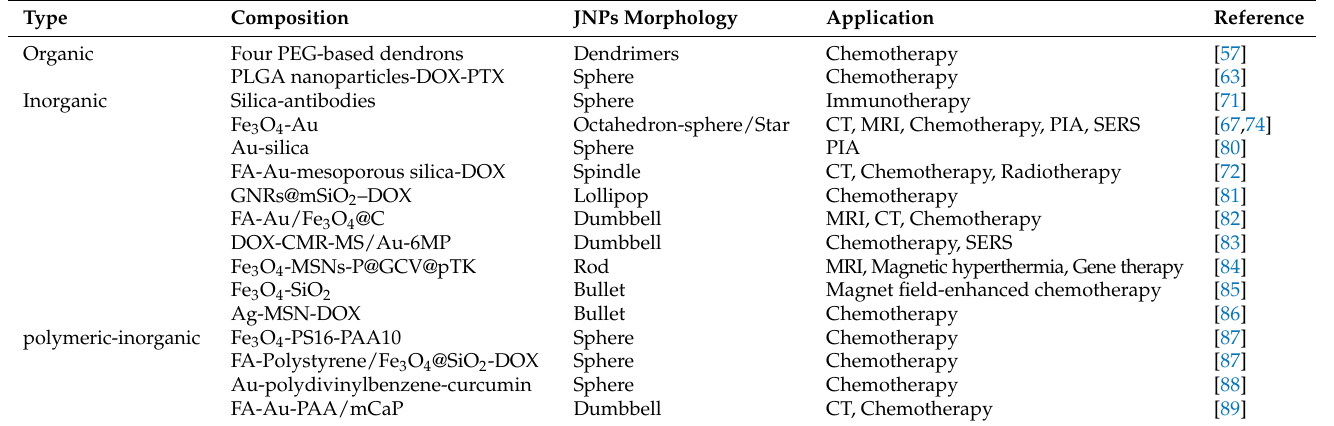
Table 2. The examples of employed JNPs in the studies related to cancer diagnosis and treatments.